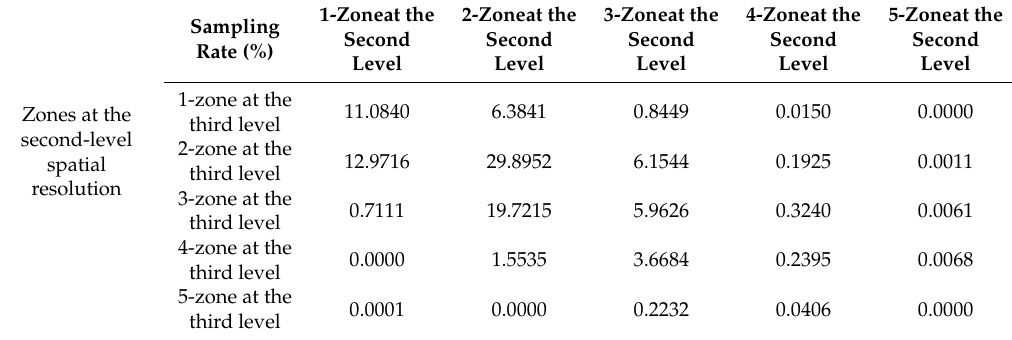
Table 4. Sampling rate of each zone at the second-level spatial resolution